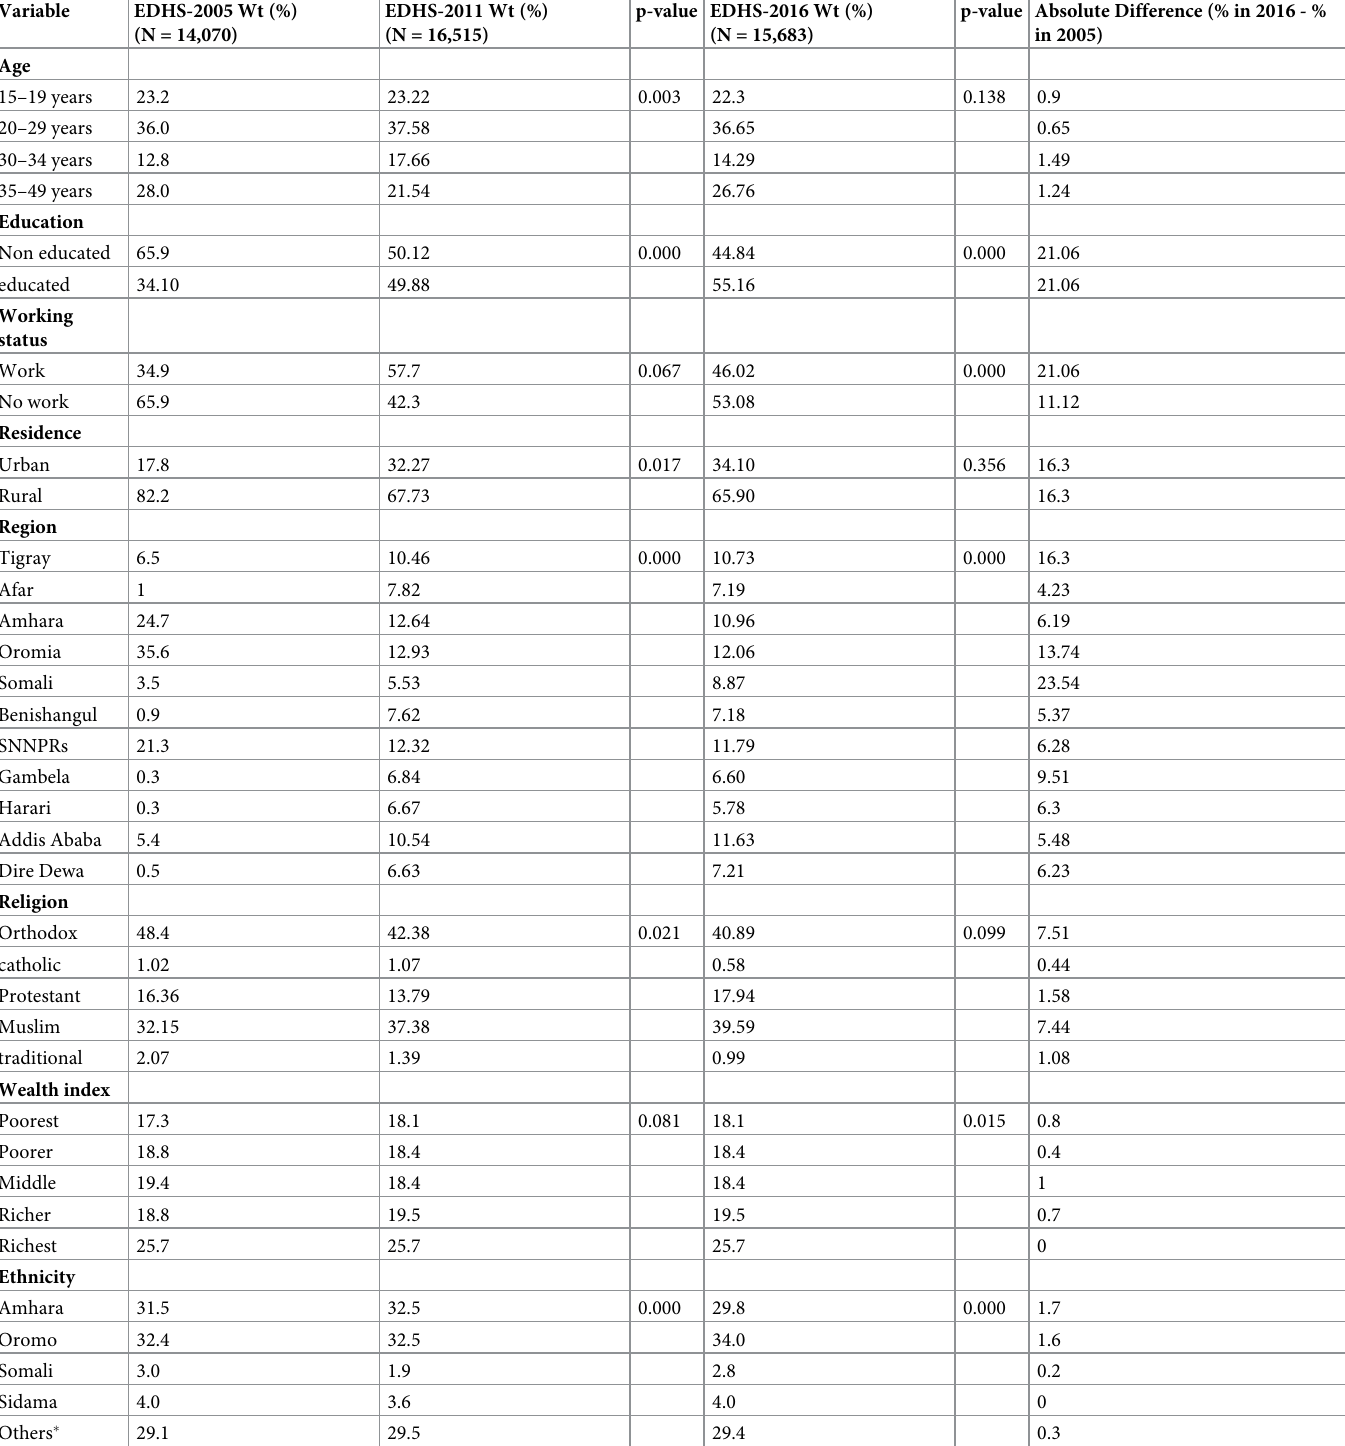
Table 1. Socio-demographic characteristics of women from EDHS 2005-2016(N =